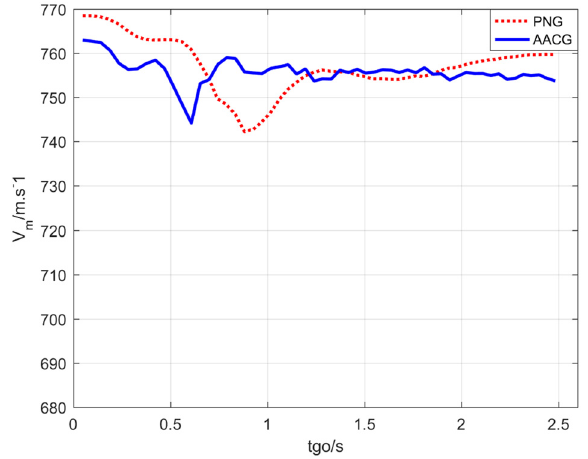
Figure 22: Aim point jumping t go – terminal